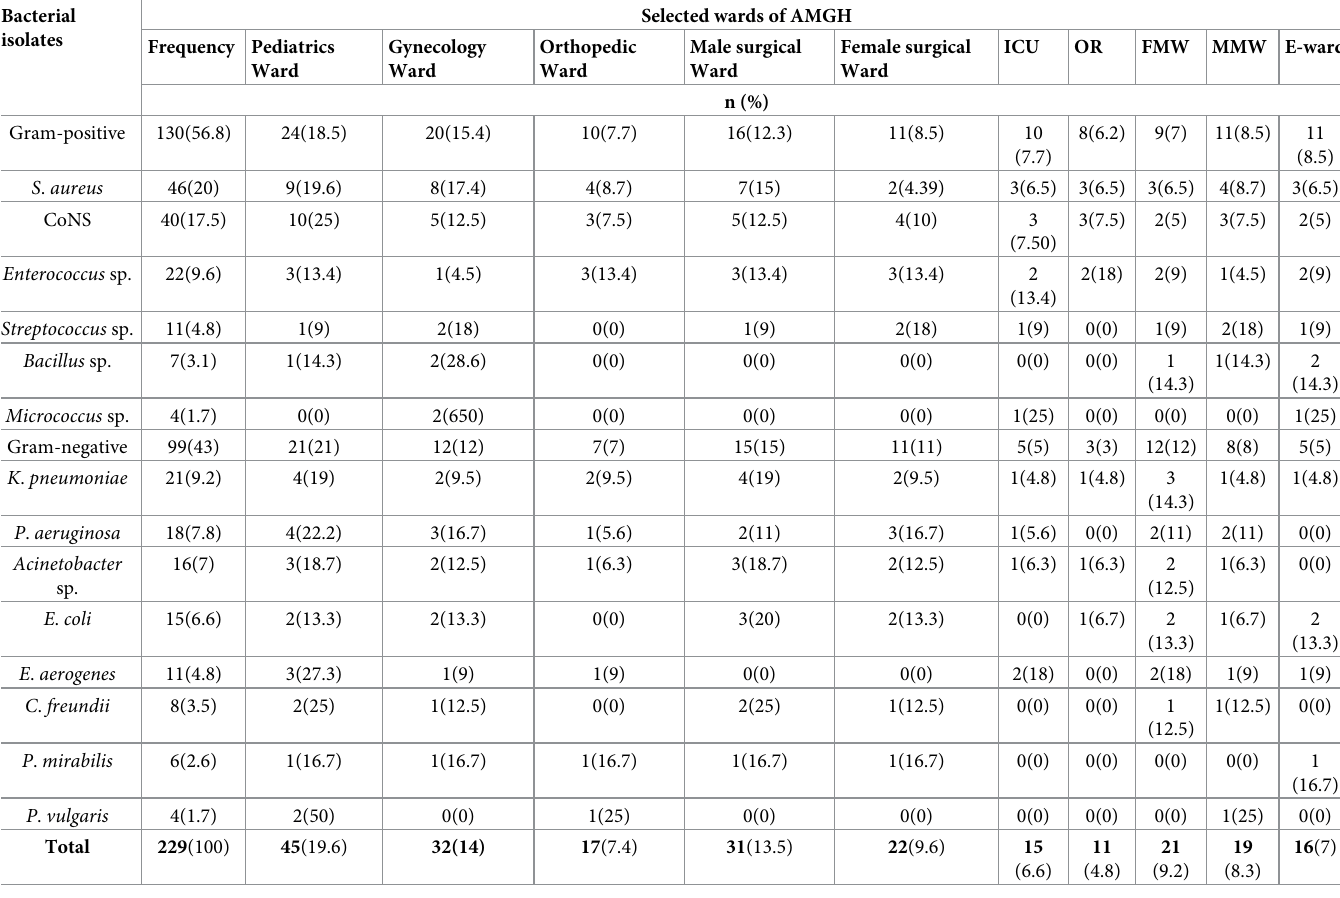
Table 2. Profiles of bacterial isolates identified from the indoor air of selected wards of AMGH, February-April 2021. Bacterial isolates